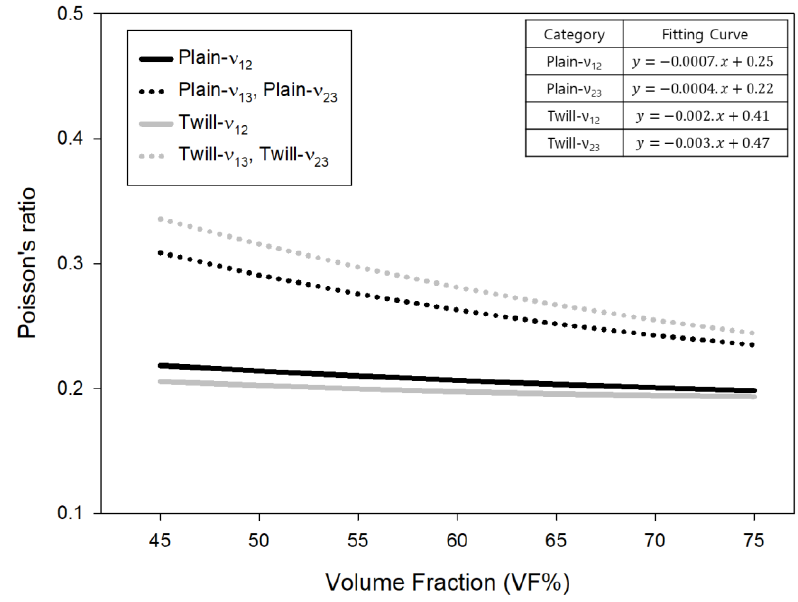
Figure 5. Comparison of the predicted values of Poisson ’s ratio .